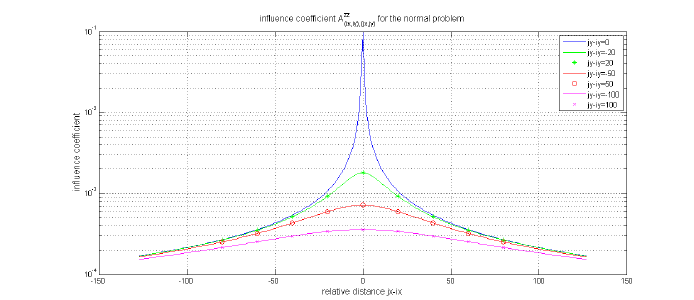
Figure 2. Influence coefficient A zz